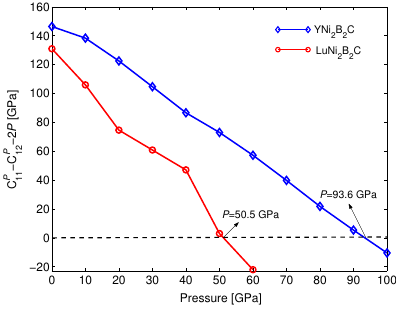
− C P − 2 P versus pressure for RNi 11 12